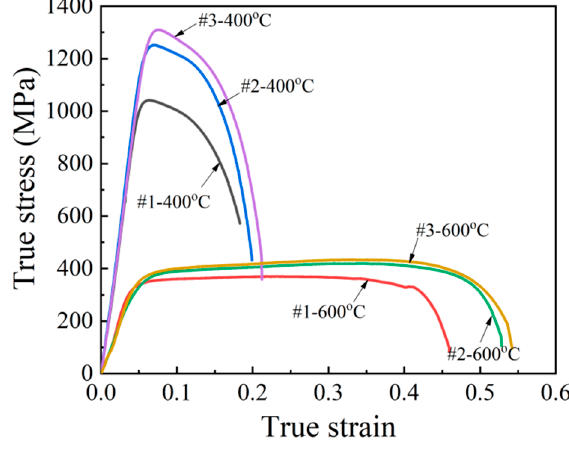
Figure 14. Tensile stress–strain curves of the tensile specimens at various temperatures with a fixed strain rate of 1 s − 1 .